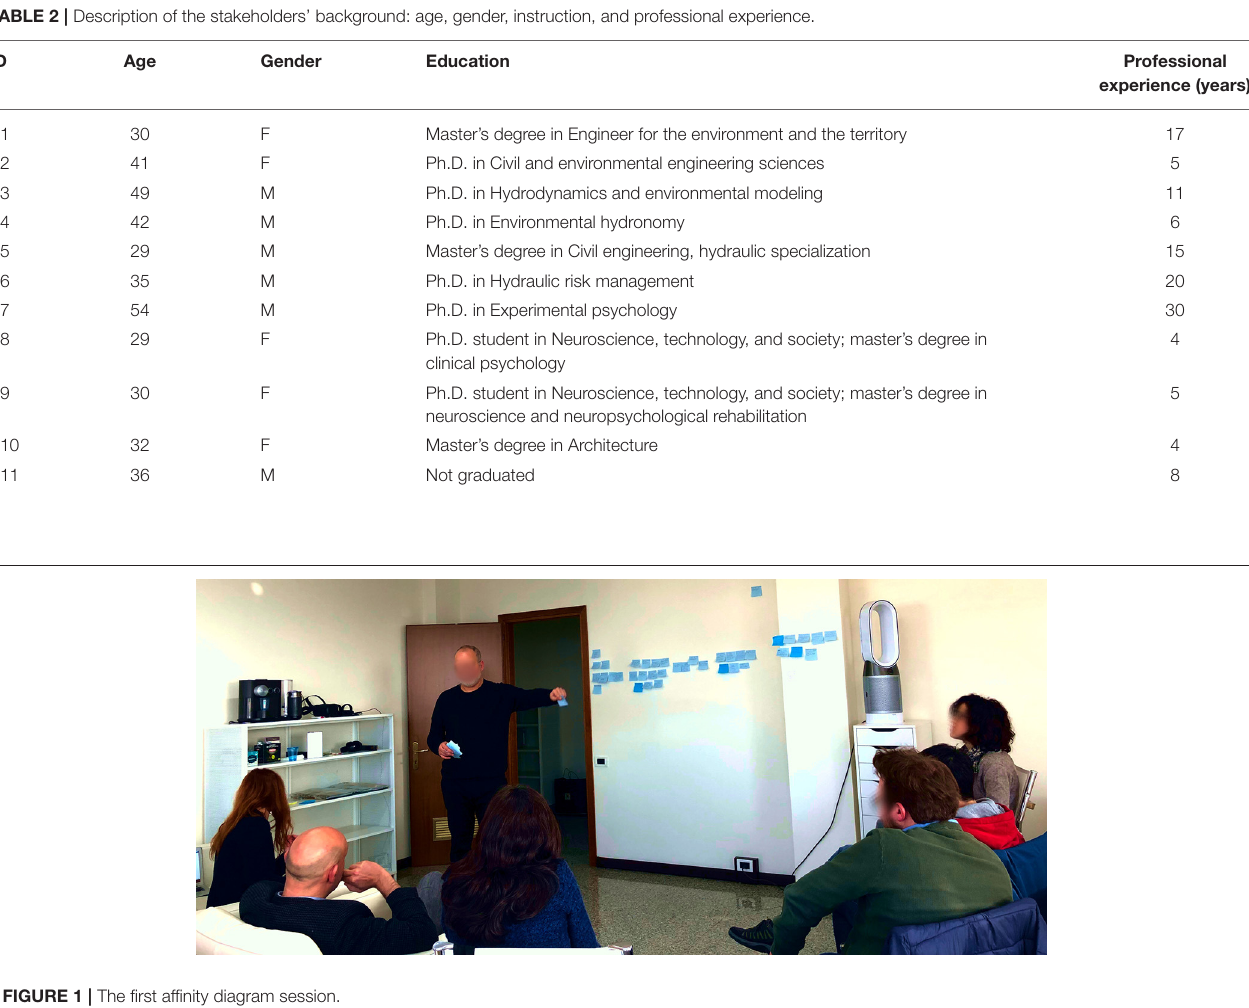
TABLE 2 | Description of the stakeholders’ background: age, gender, instruction, and professional experience.